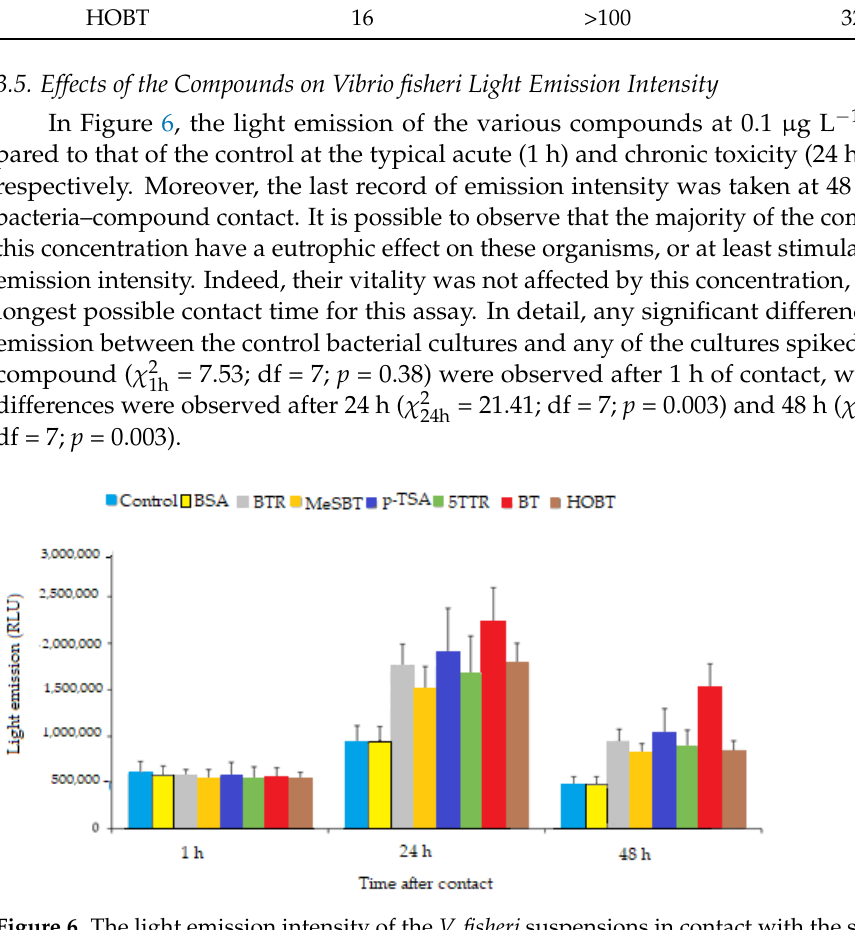
Figure 6. The light emission intensity of the V. fisheri suspensions in contact with the seven benzo- fused nitrogen heterocycles, all at the 0.1 µg L − 1 concentration.